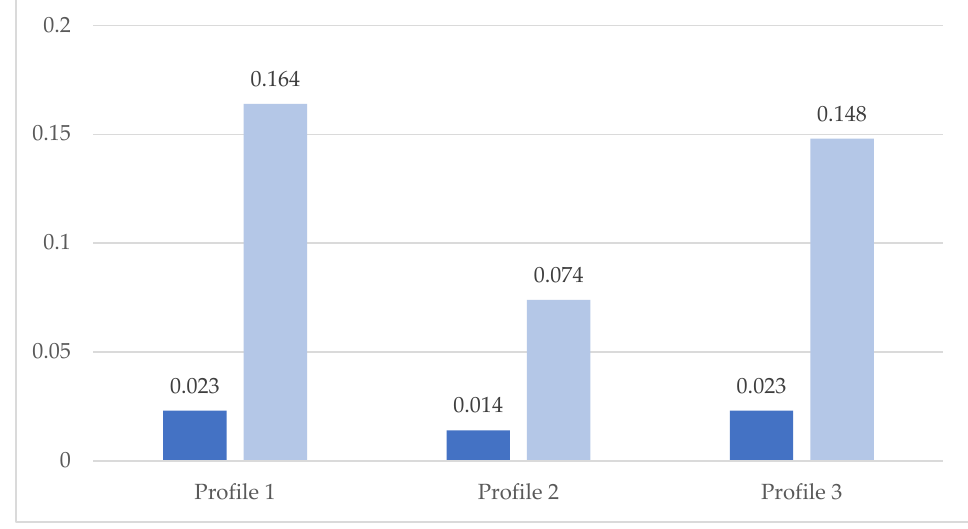
Figure 36. RMSe (m) analysis of the ICP alignment related to custom profiles: Zenmuse P1 in blue and Zenmuse L1 in light blue.